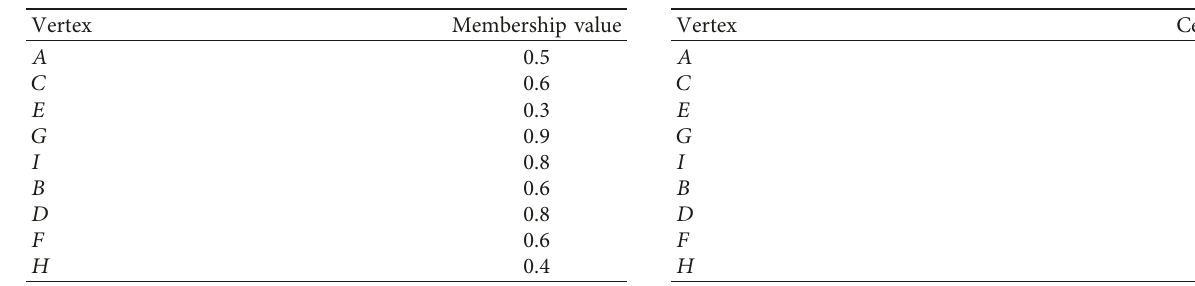
Table 2: Vertex membership value of Figure 1.